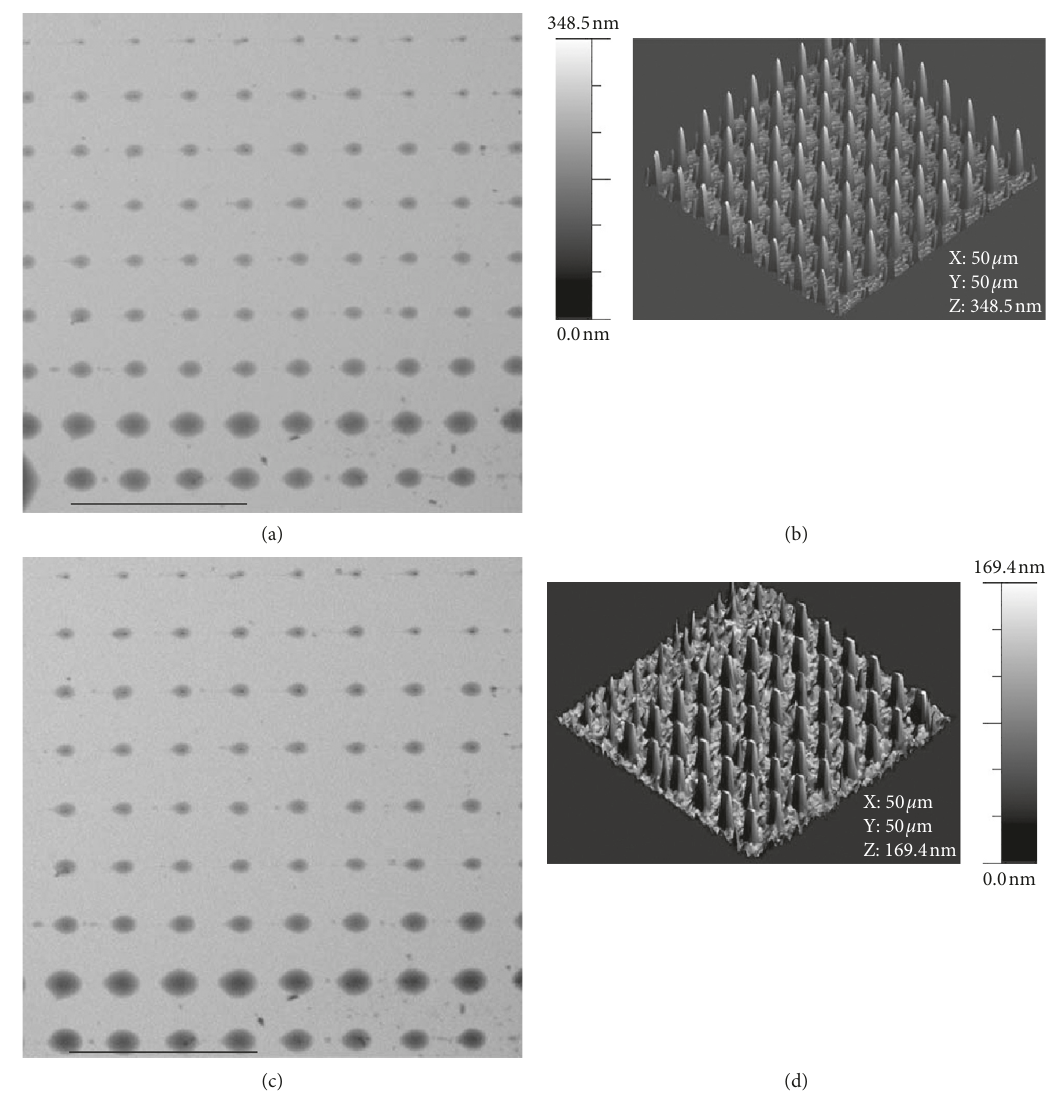
Figure 2: SEM and AFM images of the polymeric dot pattern on silicon (a, b) and gold (c, d). The bars in (a) and (c) are 20 µ m.